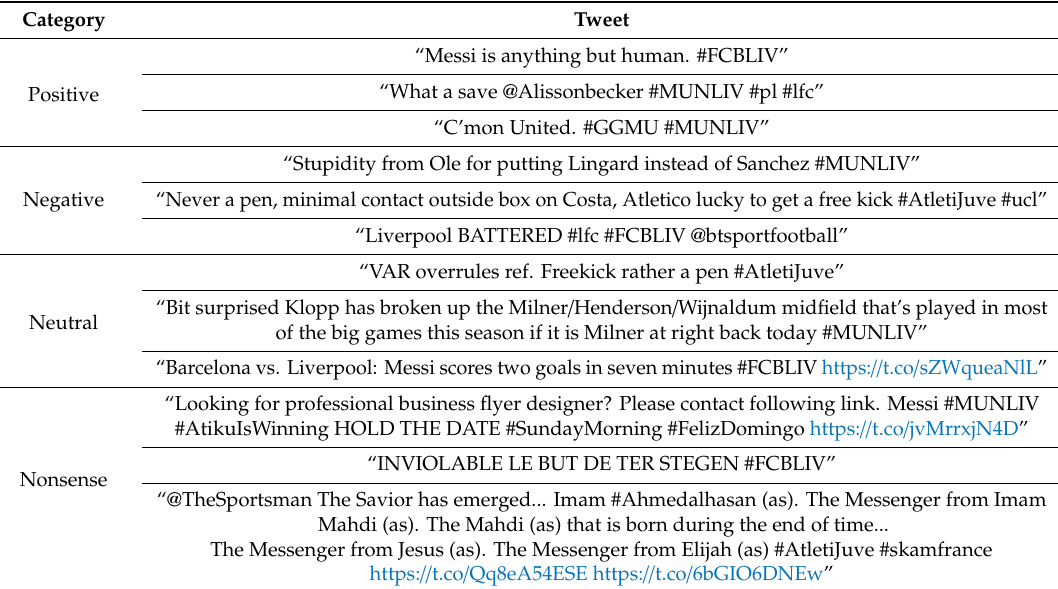
Table 3. Example tweet in each category of the manual